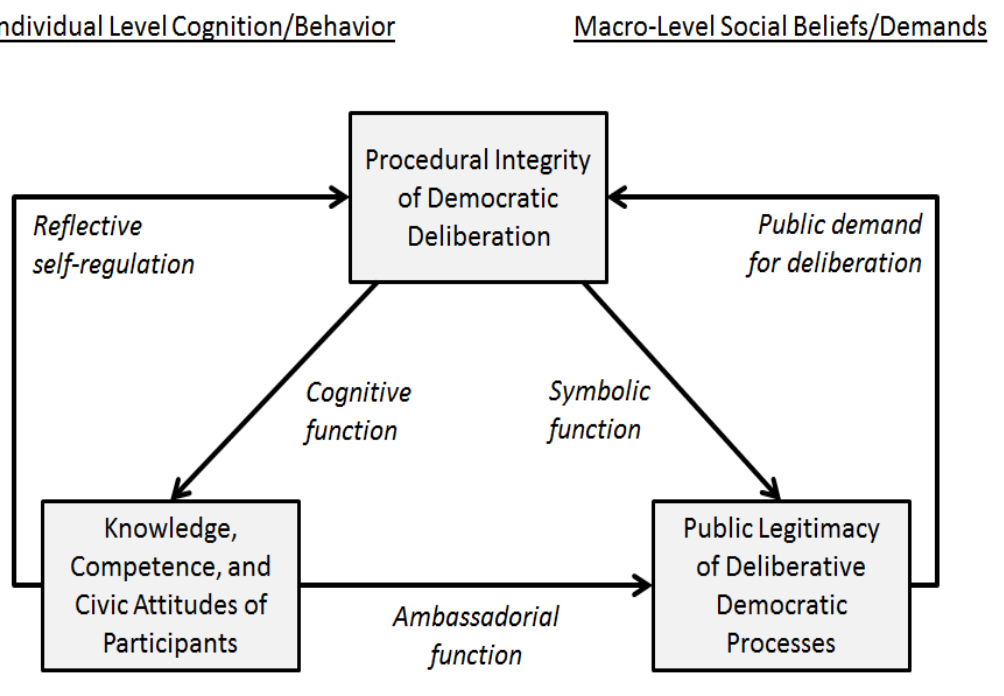
Figure 1. The empirical content of the symbolic-cognitive proceduralism